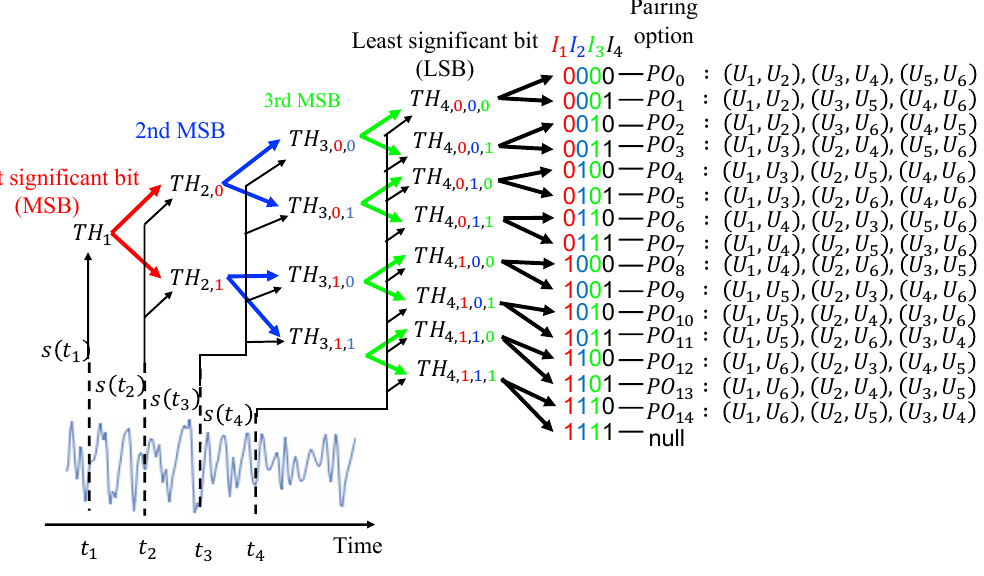
Figure 6. User pairing using the laser chaos decision-maker in the NOMA system in the case of 6 users. For each of the bits, the decision is made based on a comparison between the sampled amplitude of the laser chaos time-series and the specified threshold value. First, the level of chaotic output s ( t 1 ) measured at t = t 1 is compared to a threshold value given as TH 1 . The output of the comparison is instantly the decision of the MSB related to selecting the pairing option. If s ( t 1 ) is larger than or equal to TH 1 , the MSB of the pairing option is decided to be 0, which we donate as I 1 ( MSB ) = 0. Otherwise, the MSB is decided as 1 ( I = 1 ) . Based upon the decision of the MSB, the sampled amplitude of the laser chaos 1 time-series s ( t 2 ) , measured at t 2 , is compared to another threshold value denoted as TH 2,0 or TH 2,1 . In the case of I 1 = 0, s ( t 2 ) is compared to TH 2,0 . The first number two in the TH 2,0 ’s subscript states corresponds to the second MSB, and the second number zero in the subscript states corresponds to the value of the I 1 . If s ( t 2 ) is greater than or equal to the threshold TH 2,0 , the second MSB is set to be zero, i.e., ( I 2 = 0 ) , otherwise it is set to be one, i.e., ( I 2 = 1 ) . In these rules, the threshold value comparison finishes when all M bits information of the specified option are decided. The update formula of the threshold adjuster value TA can be expressed as follows